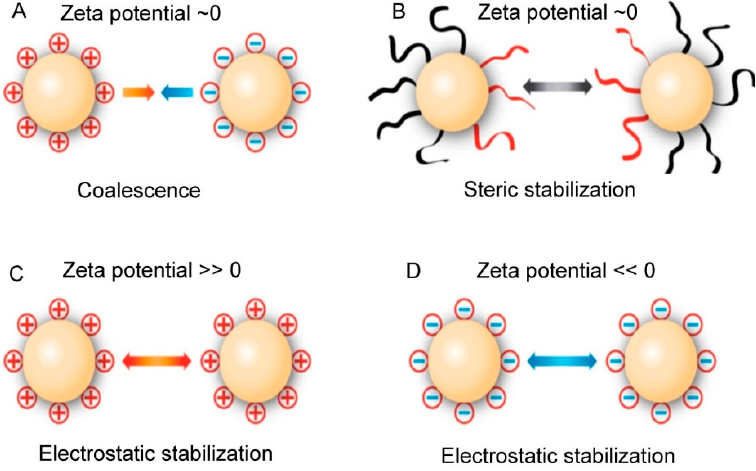
Figure 5. Influence of zeta potential on particle-particle interaction.